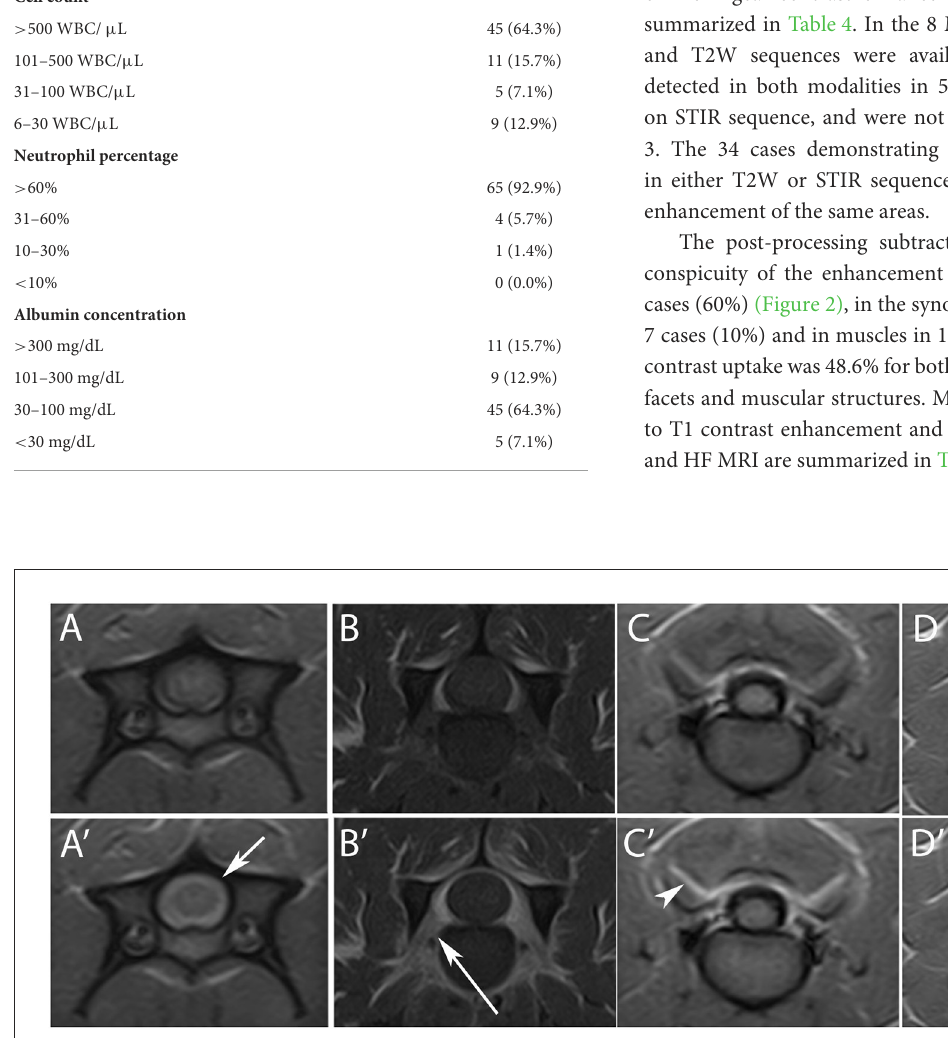
FIGURE1 Transverse T1W images pre- (upper row) and post- (lower row) contrast agent administration, at level of C4 (A,A’,D,D’) , C5–C6 (B–B’) , and C2–C3 (C–C’) . A marked contrast enhancement is evident at the level of the meninges [ (A’) —short arrow], nerve roots [ (B’) —long arrow], synovium of the articular facets [ (C’) —arrowhead], and muscles [ (D’)